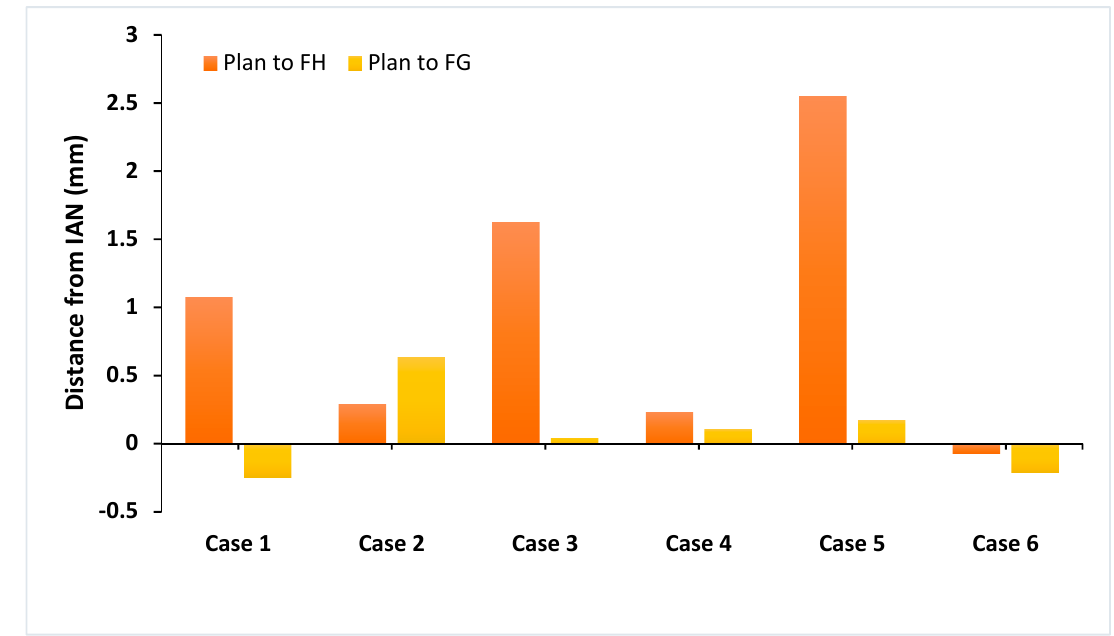
Figure 4. Indicates the deviation from the planned implant position and distance from inferior alveolar nerve (IAN). Negative values indicate a final position closer to the IAN than planned.